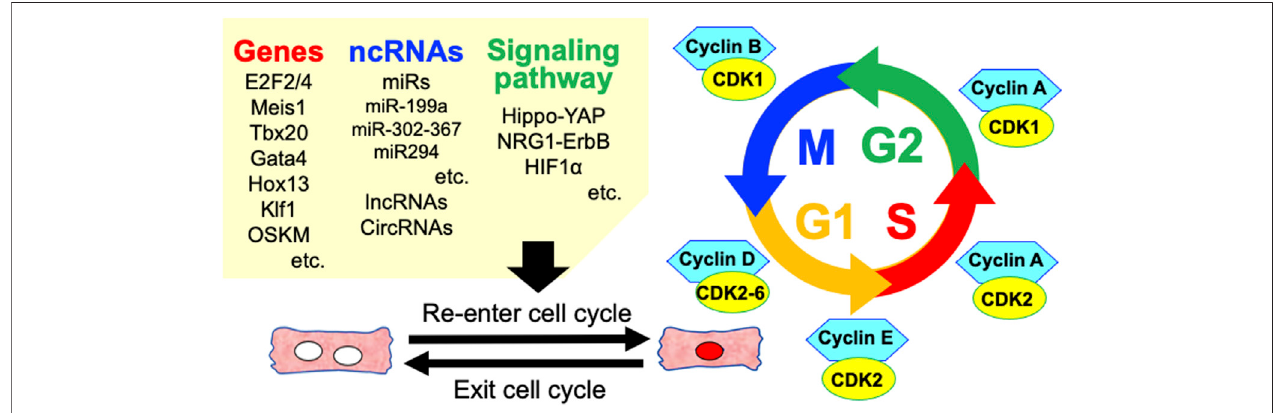
FIGURE 3 | Various factors involved in the regulation of cardiomyocyte cell cycle re-entry. ncRNAs, non-coding RNAs; miRs, microRNAs; lncRNAs, long non- coding RNAs; circRNAs, circle RNAs.